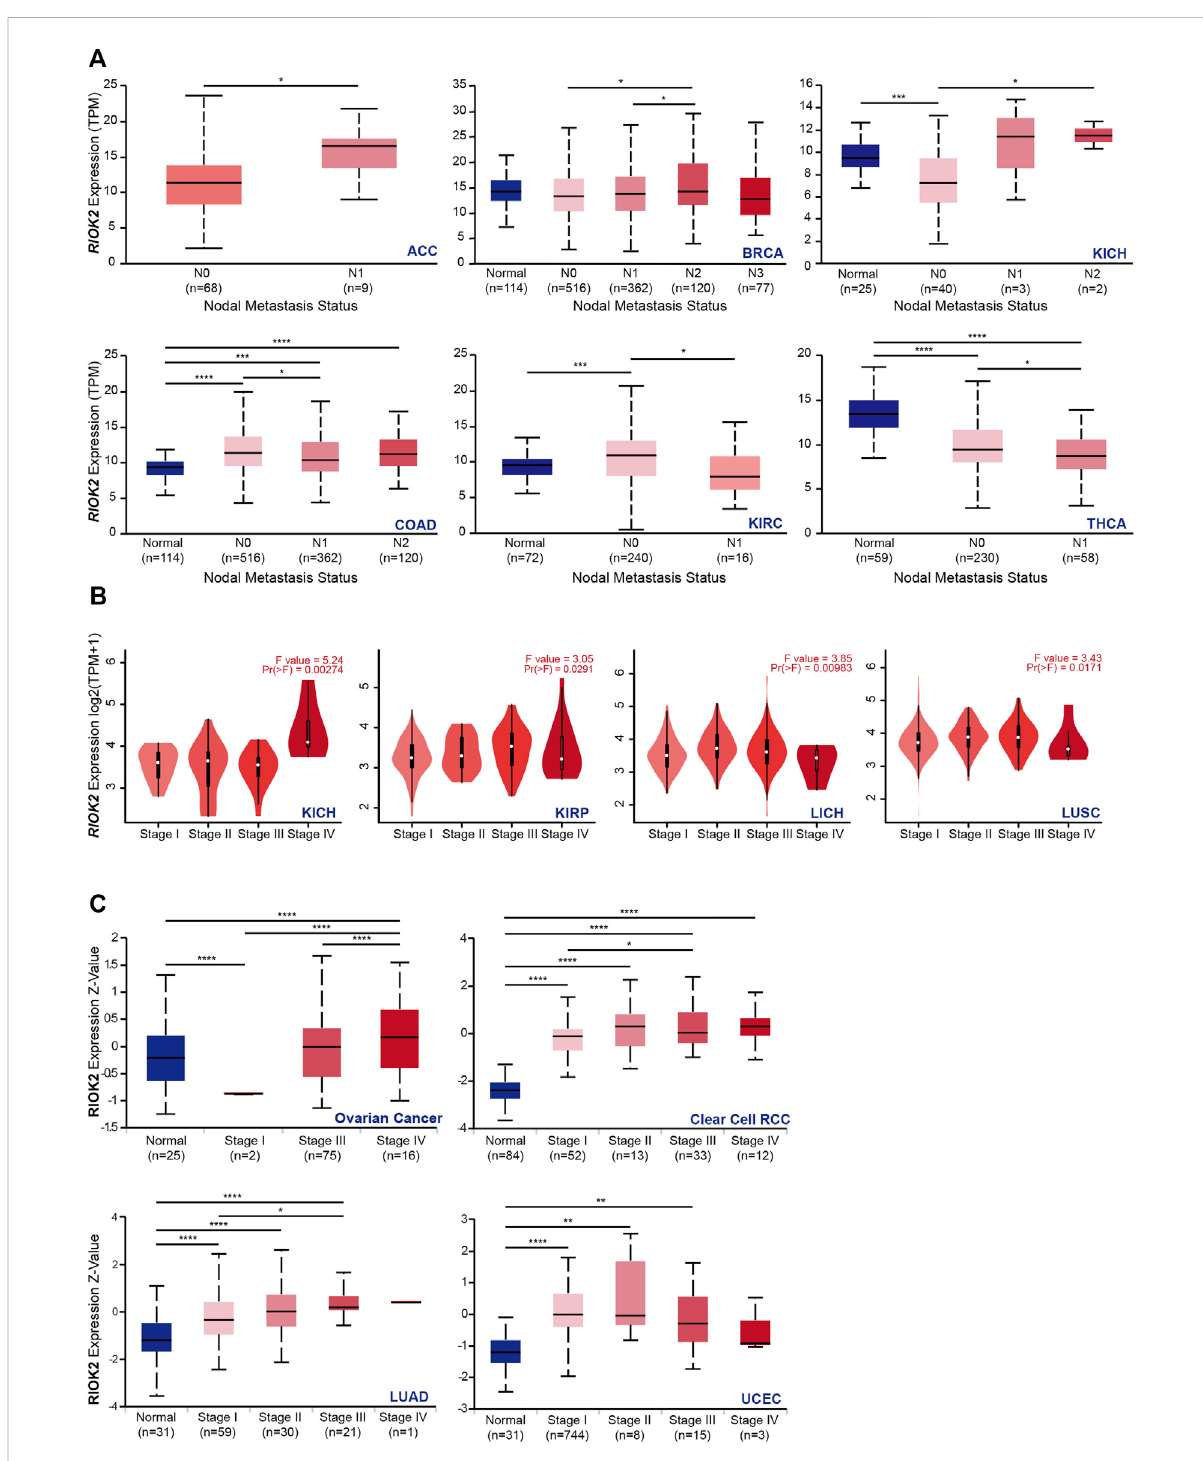
CorrelationbetweenRIOK2geneexpressionandlymphnodemetastasisandfourpathologicalstagesofcancers. (A) Boxplotsrepresentingthe RIOK2 mRNA level calculated by TPM (y-axis) for each nodal metastasis status of TCGA cancer types (x-axis). The blue box represents the healthy group, and the red one represents the tumor group. The nodal metastasis status is divided into N0, N1, N2, and N3. Among them, N0 indicates no regional lymph node metastasis; N1 indicates metastases in 1 – 3 axillary lymph nodes; N2 indicates metastases in 4 – 9 axillary lymph nodes; N3 indicates metastases in ten or more axillary lymph nodes. (* p < 0.05; ** p < 0.01; *** p < 0.001; **** p < 0.0001). (B) The expression of RIOK2 in TCGA RNA-Seq datasets in four pathological stages (stages I – IV) were calculated by mean value of log2 (TPM +1) using violin plots. (C) The expression of RIOK2 at protein level in pathological stages I – IV was evaluated by Z-value using box plots. (* p < 0.05, ** p < 0.01, *** p <